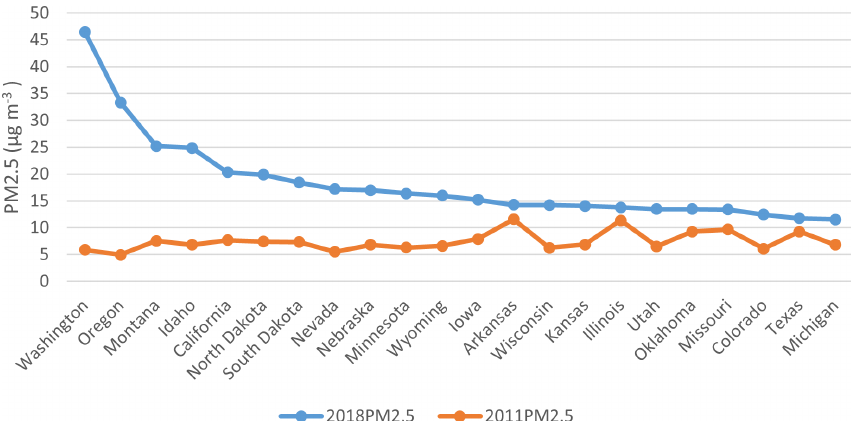
Figure 5. Mean PM 2 . 5 from 9 to 25 August 2018 and 2011 of most affected states.